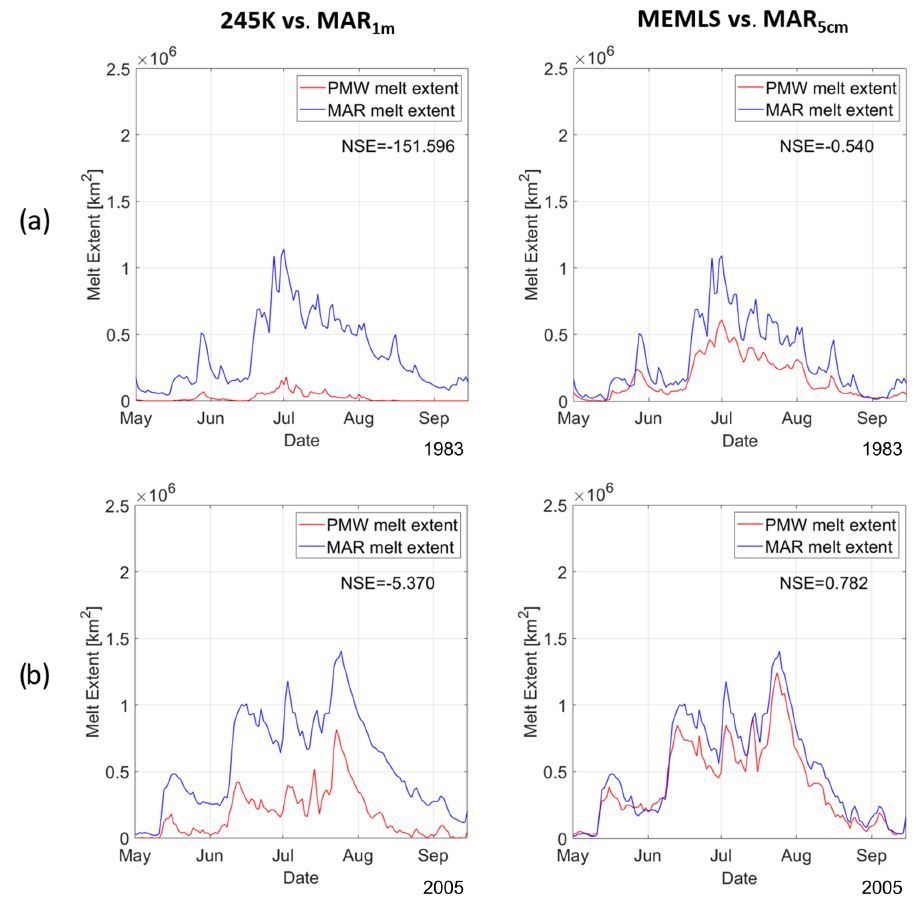
Figure 8. Melt extent estimation from PMW 37GHz horizontally polarized T b (red) and the MAR (blue) regional climate model. Time series were obtained using the 245K algorithm and the LWC average in the first 1m of the snowpack (left), and the MEMLS algorithm and the LWC average in the first 5cm of the snowpack (right), for the years (a) 1983 and (b) 2005.